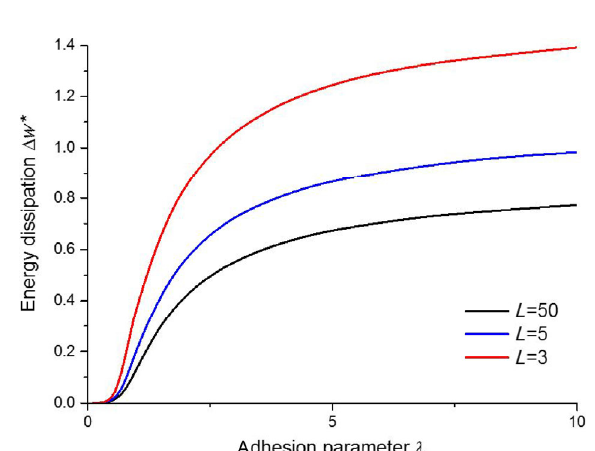
Fig. 2 Dimensionless nominal pressure vs distance in normal approach and separation of rough surfaces.